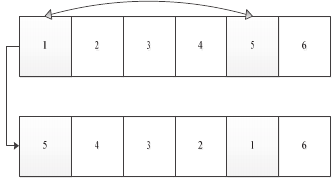
Fig. 6. Swap local search (the upper and lower tours before and after applying the local search algorithm,